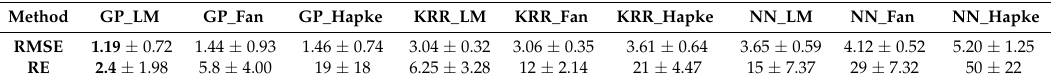
Table 3. Root mean squared error (RMSE) and reconstruction error (RE) (20 runs) of 250 test pixels of the simulated dataset. The best performances are denoted in